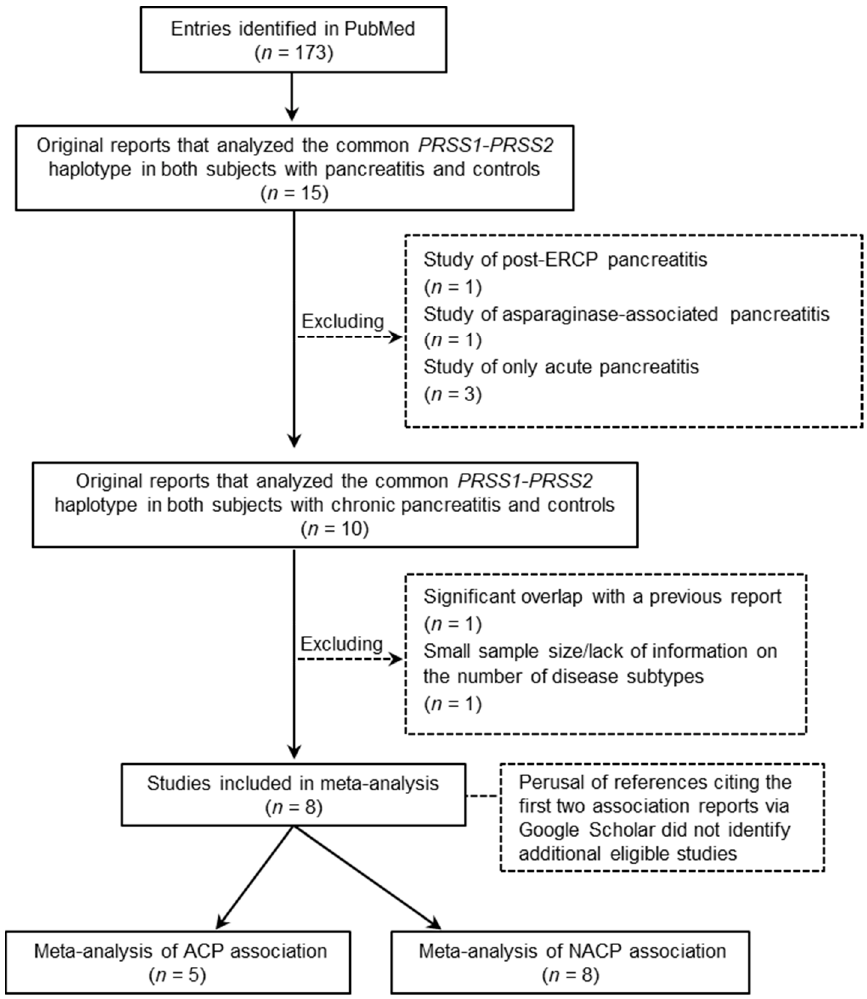
Figure 1. Flow chart of the search and selection process for the studies used for the allele-based meta-analysis. Abbreviations: ACP, alcoholic chronic pancreatitis; ERCP, endoscopic retrograde cholangio-pancreatography; NACP, non-alcoholic chronic pancreatitis.